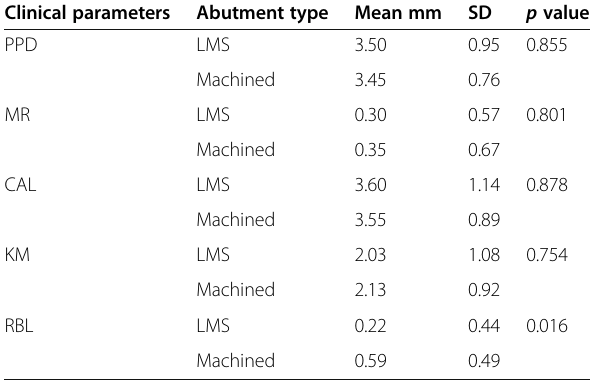
Table 3 Clinical parameters PPD, MR, CAL, BOP, KM, and RBL for M vs LMS abutments Clinical parameters